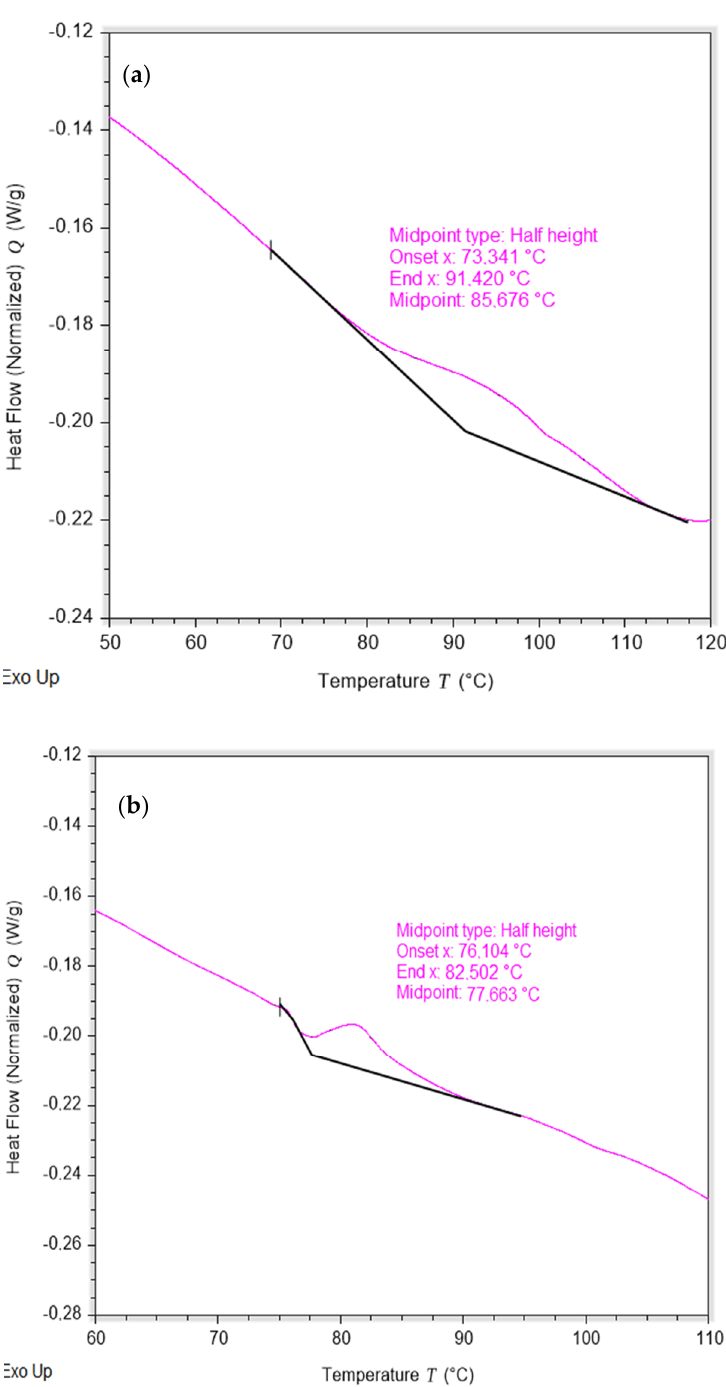
Figure 6. Di ff erential scanning calorimetry (DSC) analysis of ( a ) the polycoat 38 ® resin synthetized and ( b ) emulsion of polycoat 38 ® and Disprosol 17 ® .